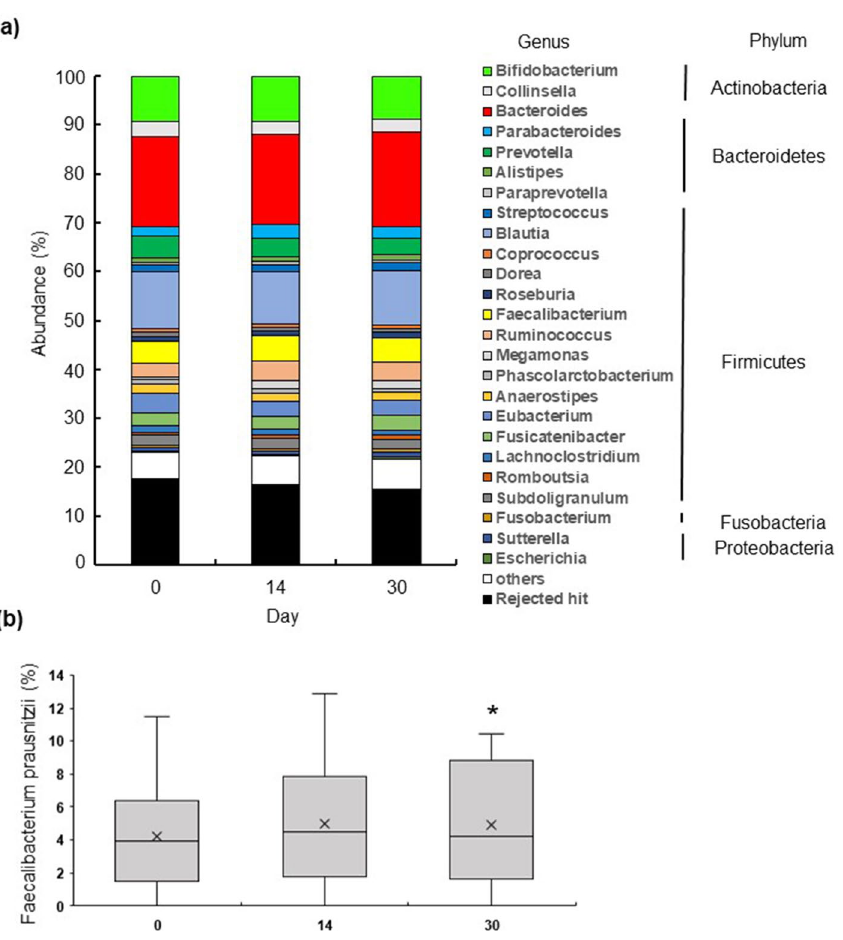
Figure 4. Euglena gracilis ingestion increases the proportion of the Faecalibacterium genus in the gut flora. ( a ) Genus-level compositional view of bacteria in human faecal samples after 0, 14, and 30 days of E. gracilis ingestion. ( b ) The relative abundances of the Faecalibacterium genus. * P < 0.05, n = 28, Wilcoxon signed rank test.